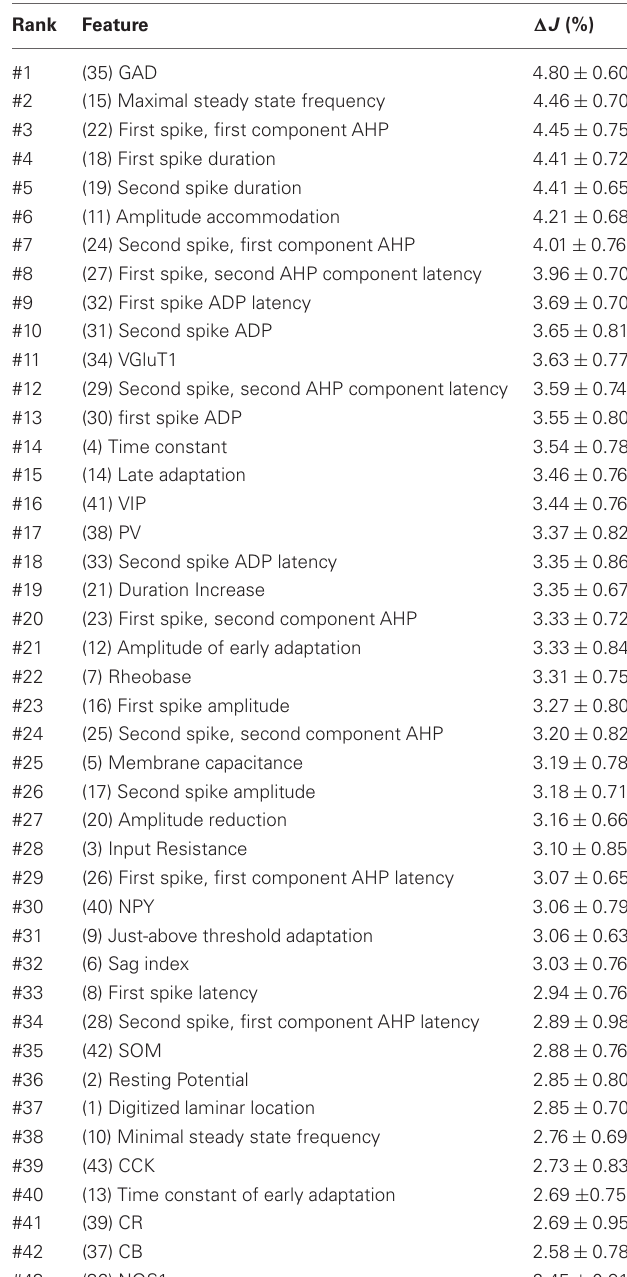
Table 7 | Relevance of properties for the classification of our